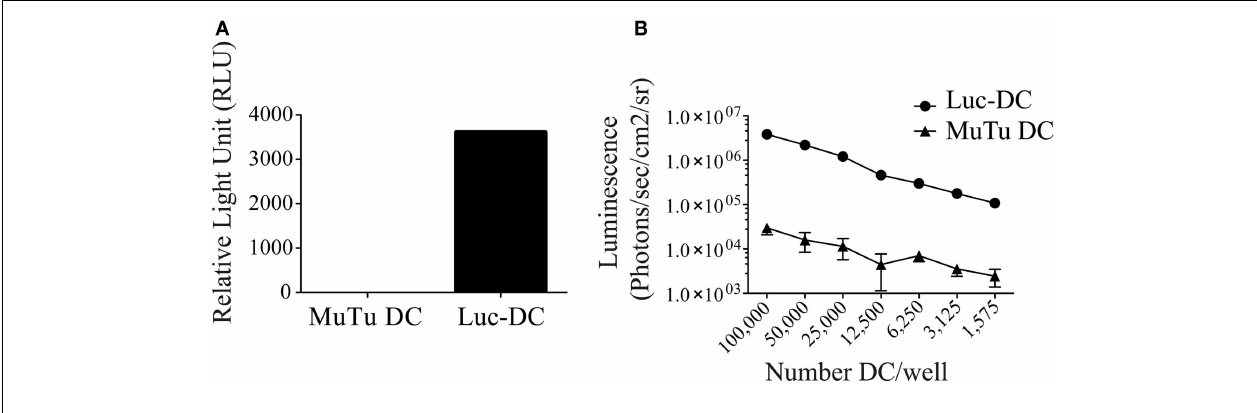
emission was measured as relative light units (RLU). (B) Different numbers of cells were plated in triplicate in a 96-well plate and the bioluminescence was monitored and quantified as photons/s/cm 2 /sr after adding 0.15mg/ml of d-luciferin by using the Xenogen imaging system. Data are presented as mean ±